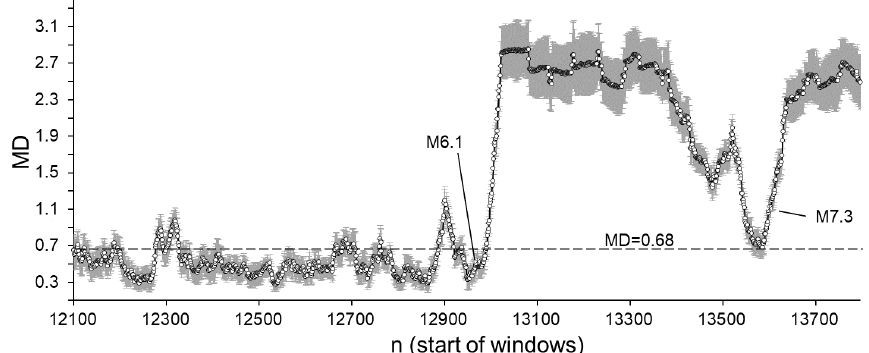
Figure 7. Average MD values calculated for the period from 14 May 1990 (12100) to 28 June 1992 (13797) in which two strong earthquakes occurred: M 6 . 1 (23 April 1992) and M 7 . 3 (28 June 1992). MD values are calculated by comparing ICT( i ), ICD( i ), and ICE( i ) sequences from the original SC catalogue and from the set of randomised catalogues. The dotted line corresponds to a significant difference between windows at p = 0 . 01. MD values are calculated for 50-data windows shifted by one data